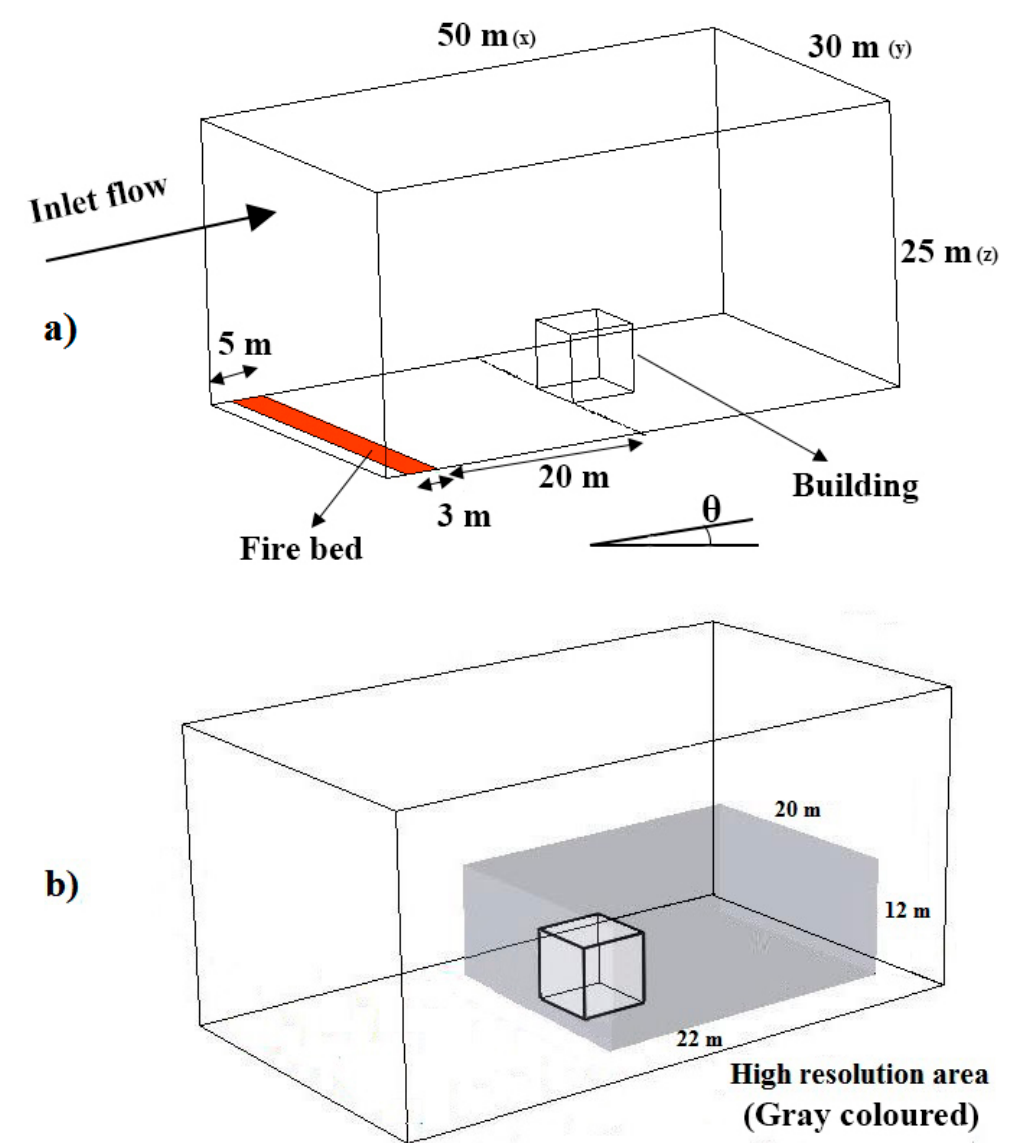
Figure 1. Schematic of computational domain and the location of the building. ( a ) Total geometry and ( b ) high-resolution mesh subdomain